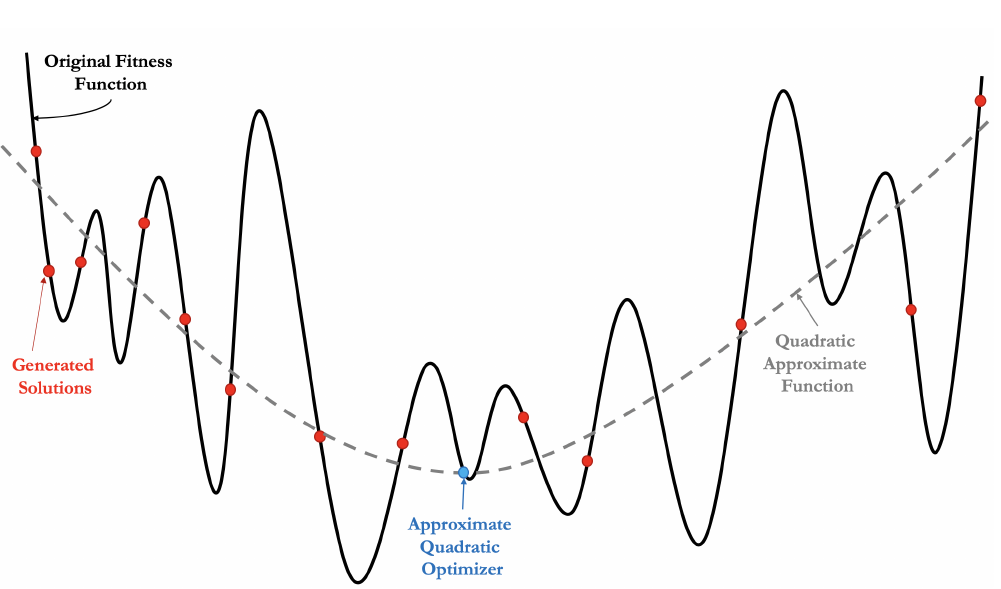
Figure 2. Representation of quadratic